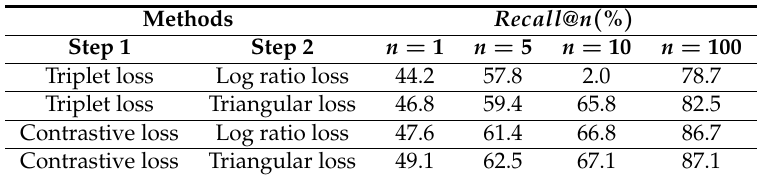
Table 3. Result of the coarse-to-fine learning method trained on the Google Earth South Korea dataset (Recall@n).